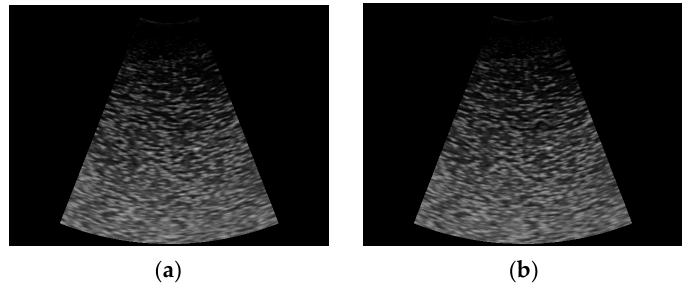
t and t t   . ( a ) The ultrasound image